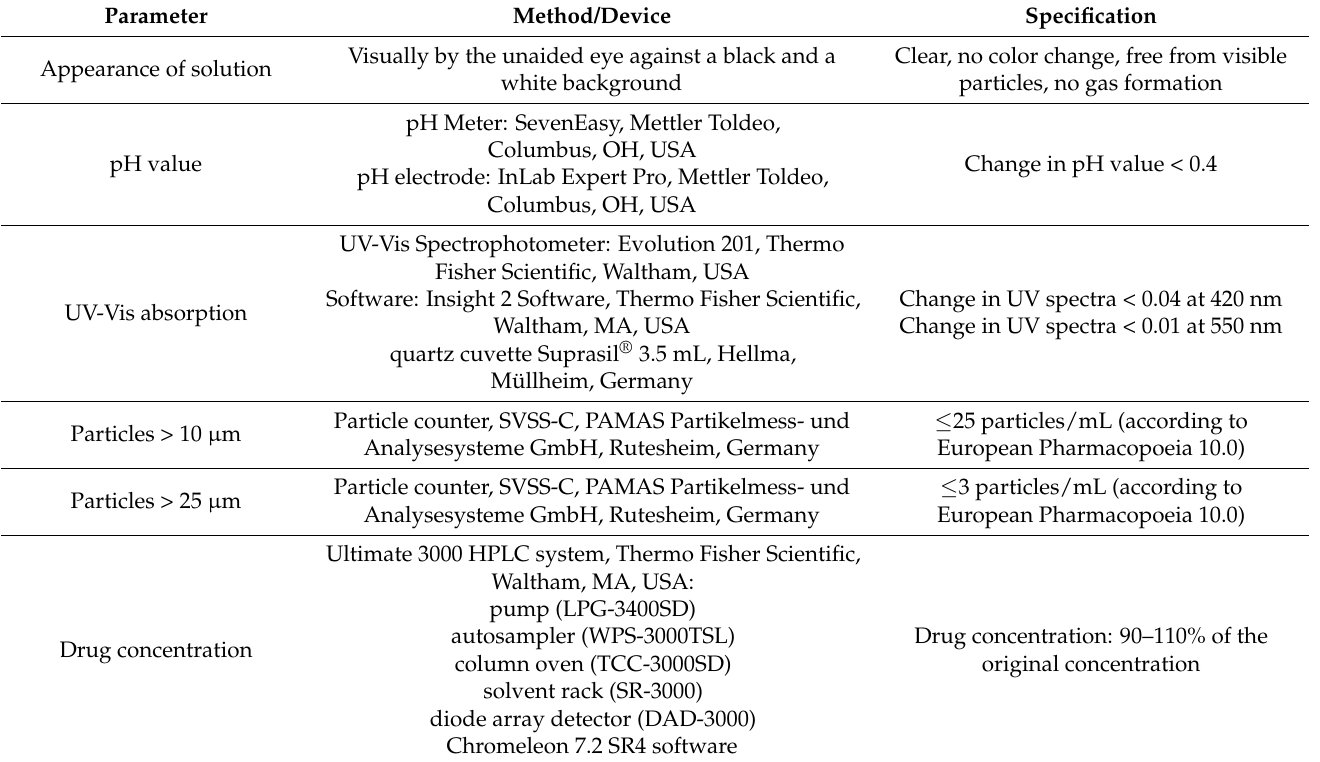
Table 2. Specifications for physical and chemical